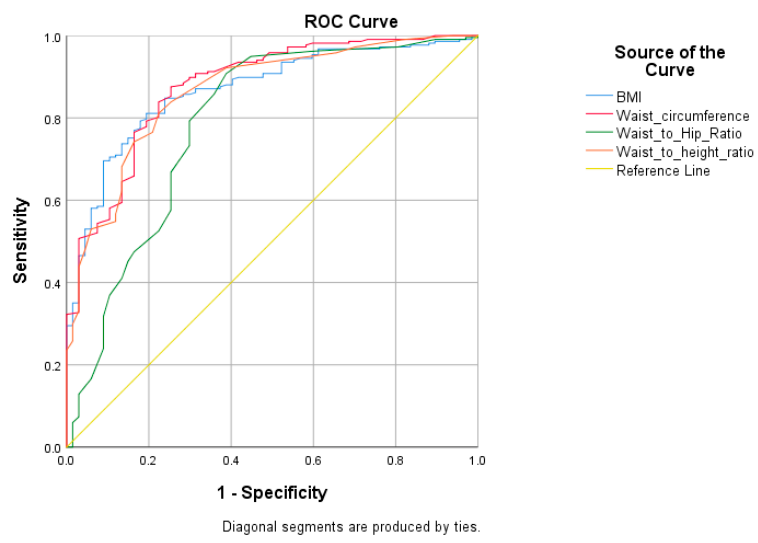
Figure 1. ROC curve for four metabolic predicator variables for hypertension.